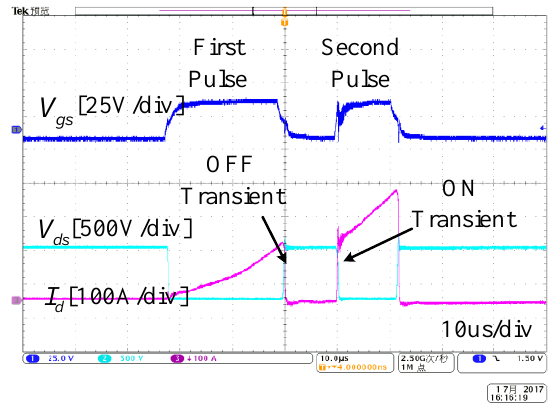
Figure 9. Waveforms of DP test.